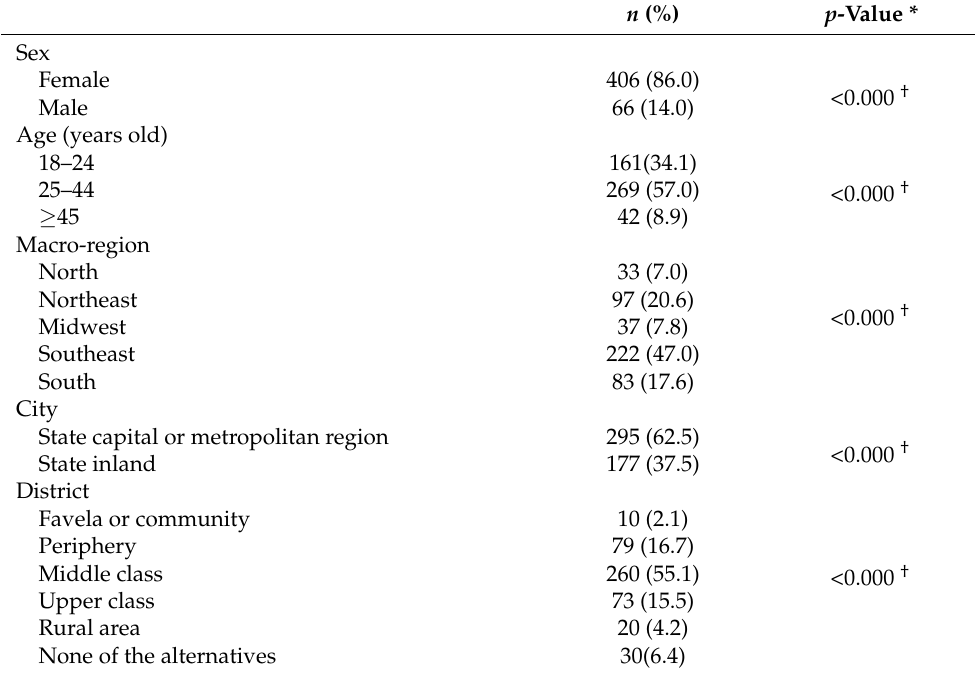
Table 1. Sociodemographic characterization of individuals with type 1 diabetes during the COVID-19 pandemic in